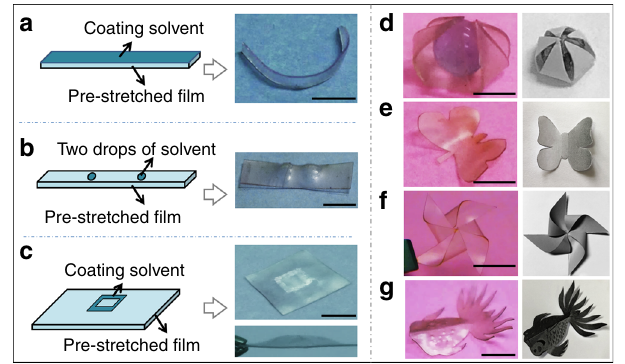
Fig. 2 Solvent-induced shape programming. a Bending a polymer fi lm by depositing solvent onto a pre-strained fi lm. Scale bar: 5 mm. b Illustration and photographs of the dot pattern by depositing two drops of THF onto a pre-strained fi lm. Scale bar: 5 mm. c Illustration and photographs of the square pattern by depositing THF with a square pattern onto a pre-strained fi lm. Scale bar: 5 mm. d A bent fi ve-point star could wrap a ball inside. The picture on the right is a model structure. Scale bar: 5 mm. e Reshaping a fl at butter fl y to a 3D “ fl ying ” butter fl y. Scale bar: 5 mm. The picture on the right is a model structure. f A bended windmill reshaped from a fl at fi lm with pre- cuts. The picture on the right is a model structure. Scale bar: 5 mm. g A complex fi sh-like 3D shape reprogrammed by solvent. The picture on the right is a model structure. Scale bar: 1 cm